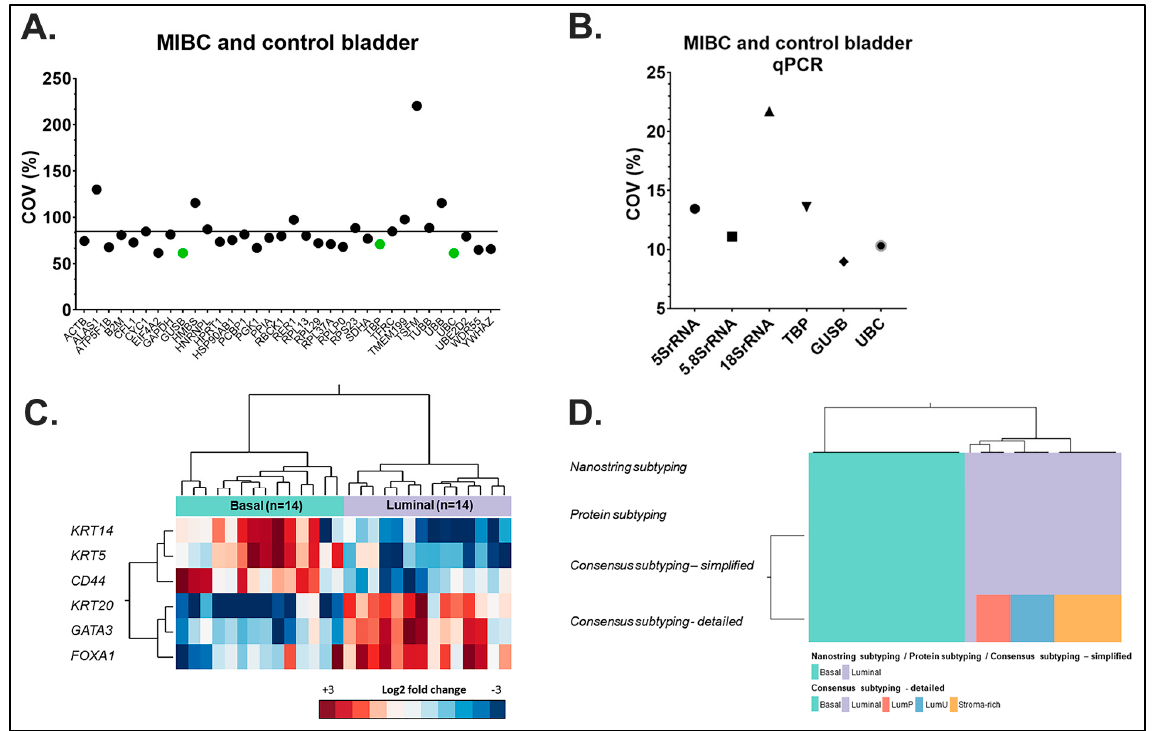
Figure 4. Identification of stable reference genes for MIBC and control tissues. ( A ) Using direct multiplex RNA-hybridization of MIBC ( n = 28) and control bladder ( n = 5), the coefficient of variation (COV) in % was calculated. Line shows mean COV of all reference genes and green points represent the most stable expressed reference genes. ( B ) Graph ( Y -axis) demonstrates the COV % of six different reference genes using qPCR: 5SrRNA (sharp circle), 5.8SrRNA (square), 18SrRNA (triangle) and confirmation of the three most stable reference genes, TBP (triangle), GUSB (diamond) UBC (blurred circle) for combined MIBC and control bladders. Although 18SrRNA showed a relative high COV of 21.7%, it represented the gene with the highest detection rate (lowest Cts). ( C ) Unsupervised hierarchical cluster analysis of 28 MIBC based on six subtyping genes (basal differentiation: KRT5 , KRT14 , CD44 ; luminal differentiation: KRT20 , GATA3 , FOXA1 ) assessed by multiplex RNA-hybridization and normalized according to the three optimal housekeeping genes GUSB , TBP and UBC . Fourteen samples were classified each as basal or luminal. ( D ) Comparison of multiplex RNA-hybridization subtyping, protein IHC subtyping (derived by IHC assessment of KRT5/CK5, KRT14/CK14, CD44, KRT20/CK20, GATA3 and FOXA1) and transcriptome consensus subtyping. Consensus subtyping is displayed in two categories: (1) “simplified” divided into a luminal and a basal category and (2) “detailed” divided into a basal and four luminal categories (luminal, luminal papillary/LumP, luminal unstable/LumU and stroma-rich). Importantly, concordance rates between multiplex RNA- hybridization subtyping and other approaches amounted to 100%; furthermore, all luminal subsets were correctly classified as luminal by multiplex RNA-hybridization